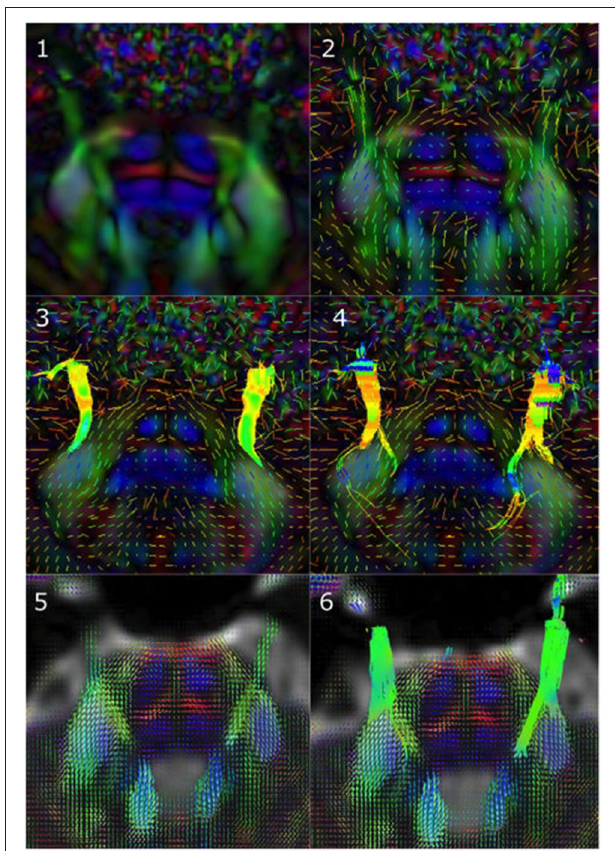
FIGURE 1 | Reconstruction methods differ in how they represent underlying diffusion processes. (1) Axial view of a sample tensor map displaying CN V entry into the brainstem, (2) Tensors visible as glyphs displaying CN V entry into the brainstem, (3) Results from single diffusion tensor tractography (SDT) after placing region-of-interest (ROI) seeds on anterior portions of CN V bilaterally. Generated streamlines do not show their projections to brainstem nuclei, (4) Results from EXtended Streamline Tractography (XST) after placing ROI seeds on anterior portions of CN V bilaterally. Streamlines projecting to the area of the nuclei of the trigeminal nerves can be seen, (5) Axial view of sample fiber orientation distribution (FOD) map displaying CN V entry into the brainstem, (6) Results from streamline tractography on FODs derived from constrained spherical deconvolution (CSD) after placing ROI seeds on anterior portions of CN V bilaterally. Streamlines projecting to the area of the nuclei of the trigeminal nerves can be seen.